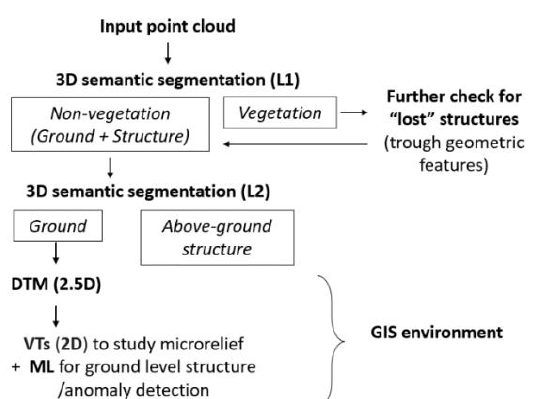
Figure 2. The proposed MLMR pipeline for processing an archaeological ALS dataset and extract hidden man-made structures under